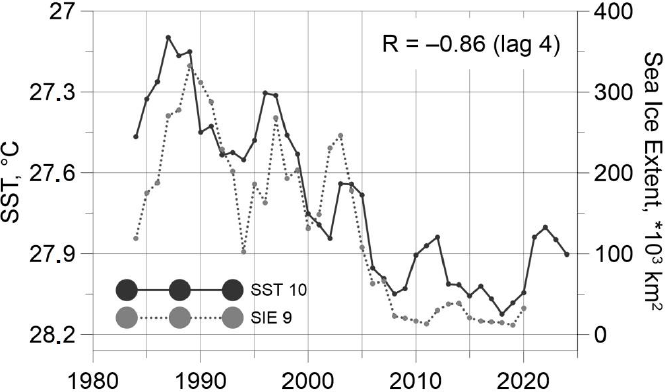
Figure 4. The sea surface temperature in area of the tropical North Atlantic in October and the sea ice extent in the Kara Sea in September with a lag of 4 years (35 months). Both series smoothed with 3-year window. R — correlation coefficient between series. Lag 4 years: 1 year (2 months) + 2 and 3 years (24 months) + 4 years (9 months) = 4 years (35 months).